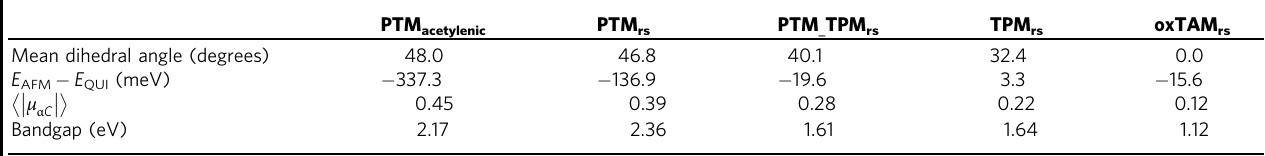
Note that, for oxTAM rs , the E AFM − E QUI value is taken as the difference between E AFM and the energy of the semimetallic solution (see SI Fig.